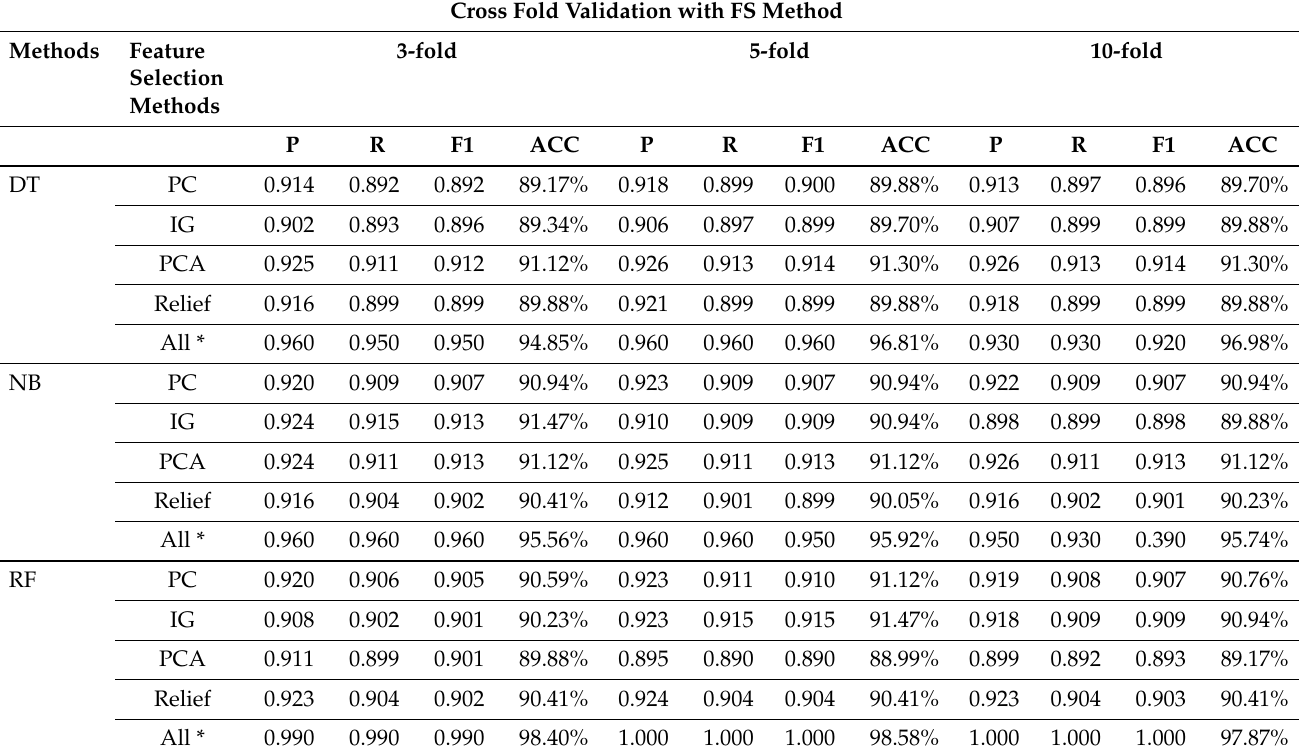
Table 8. Performance of ML models in experiment-3 (Cross Validation + FS